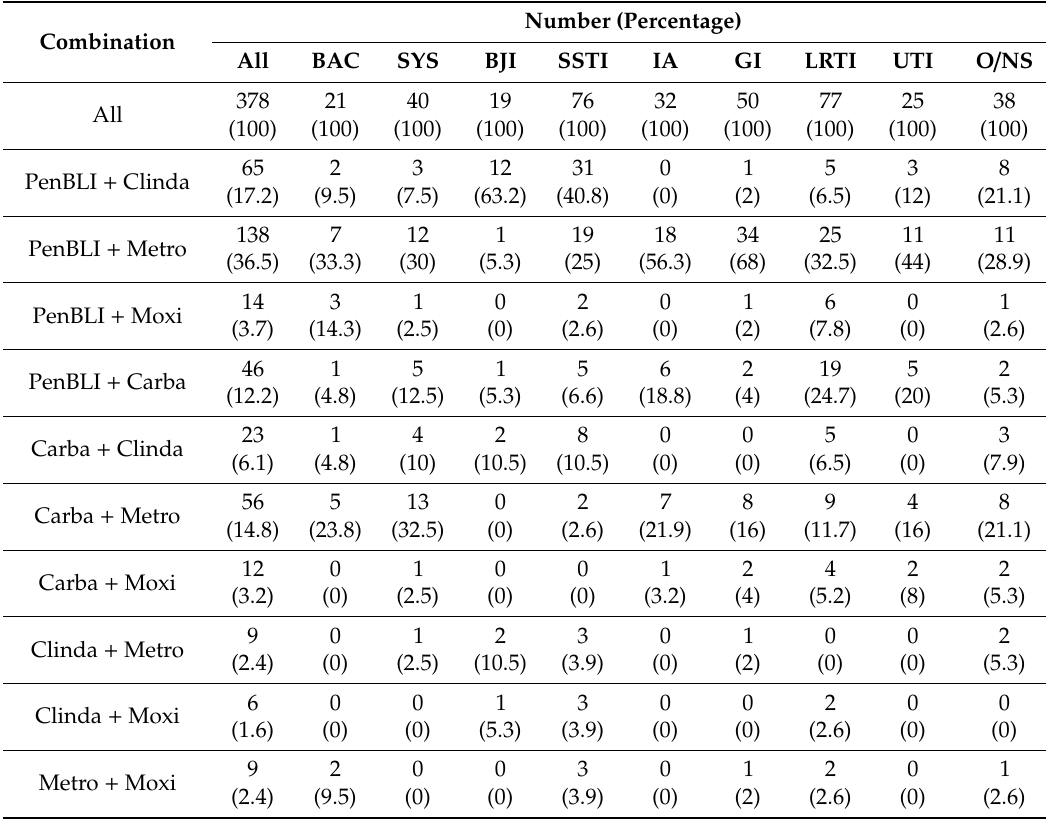
Table 5. Types of infections of redundant anaerobic antimicrobial treatment stratified by the combination of anaerobic antimicrobial agents. Data from 218 hospitals that participated in the point prevalence survey